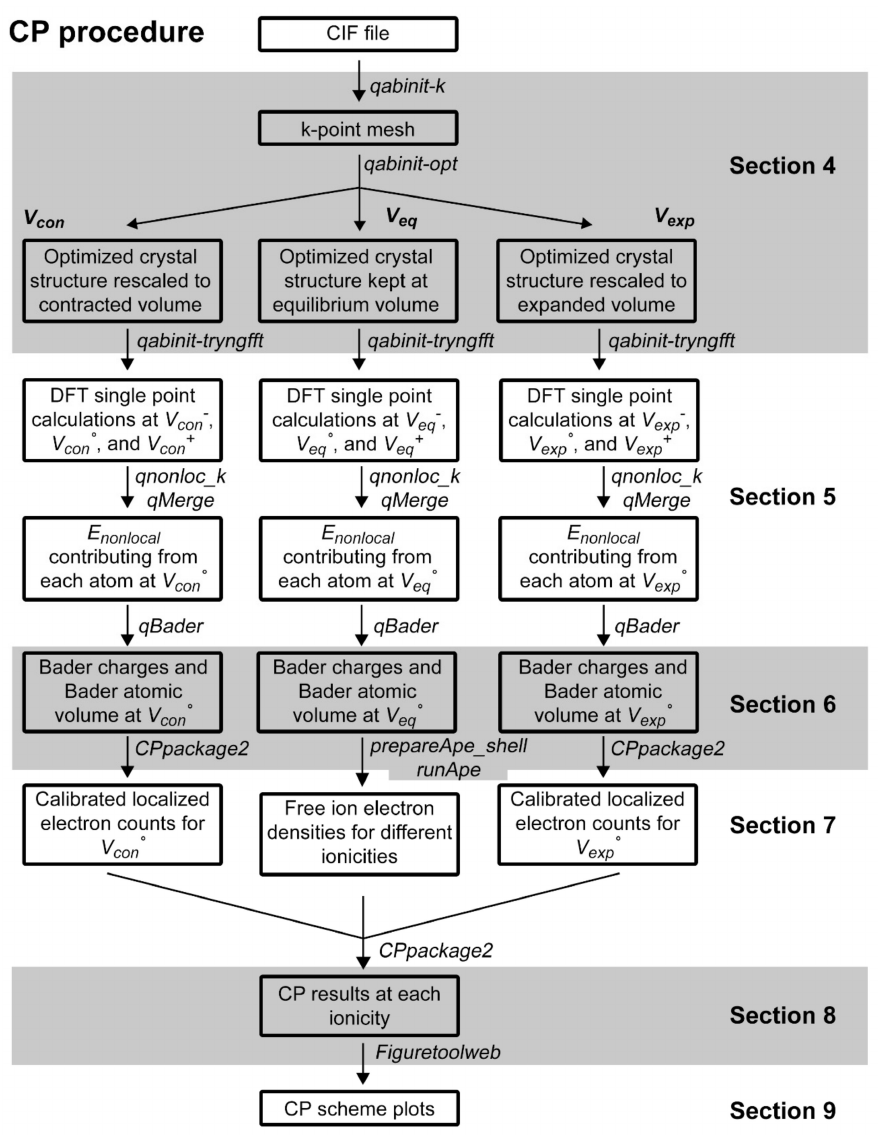
Figure 2. Flow chart of steps involved in generating a CP scheme. In this chart, the arrows are labeled with the program(s) necessary for that step and the boxes show the output obtained by the steps. The relevant section of this tutorial for each step is indicated on the